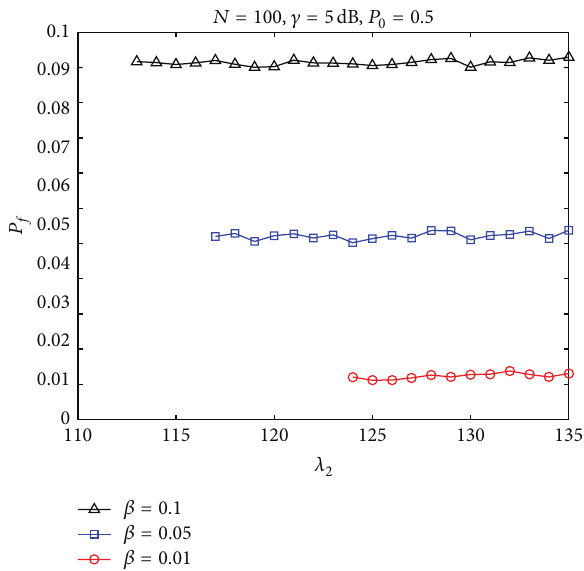
Figure 2: Final false alarm probability versus 𝜆 2 under different 𝛽 .